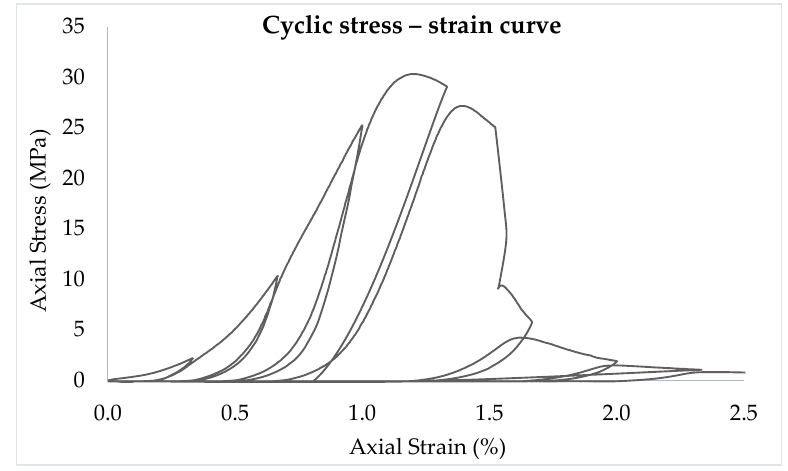
Figure 10. Axial stress versus axial strain curves of C-C0S2 concrete cylinder confined with epoxy- based SFRP under cyclic axial load.